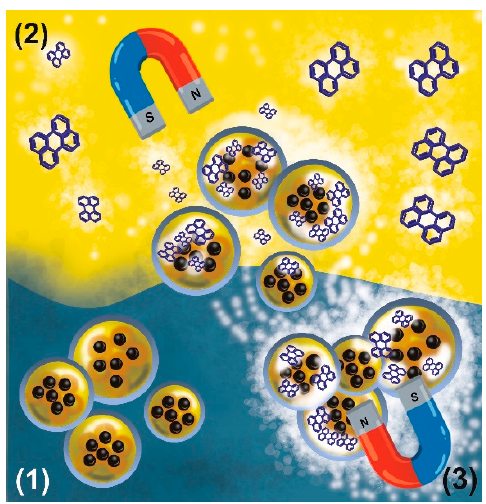
Figure 4. Magnetic navigation of the capsules with oil liquid core between two immiscible phases: ( 1 ) water with suspended nanocapsules filled with superparamagnetic iron oxide nanoparticles and ( 2 ) oil with dissolved perylene and loading process of “empty” cores with fluorescence probes; ( 3 ) drawing the loaded capsules into the aqueous phase.